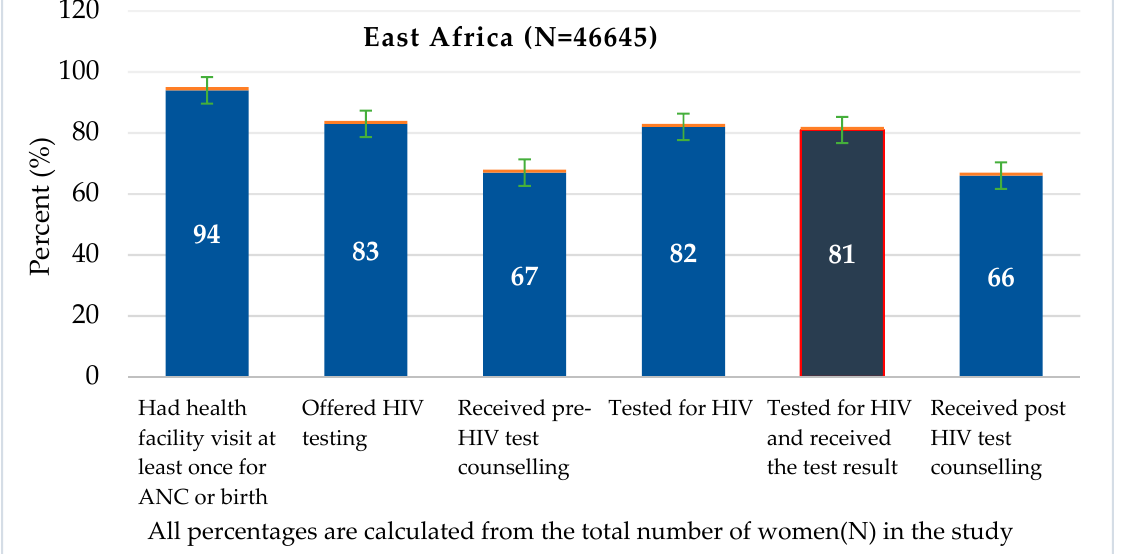
Figure 2. Health facility visits during pregnancy and HIV test services uptake in East Africa.